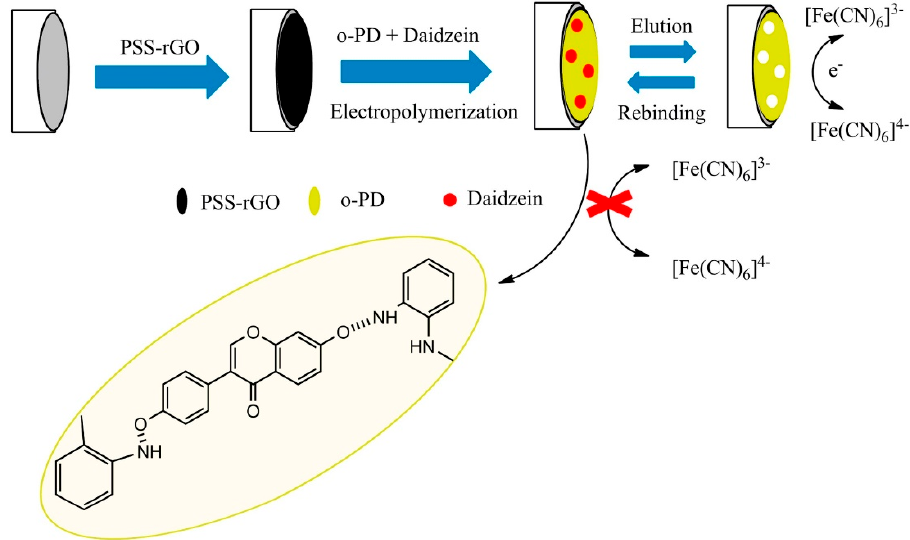
Figure 13. Schematic illustration of the synthesis procedure of molecularly imprinted polymer and the modified electrode construction process. Reprinted from ref. [119] with permission of Elsevier.